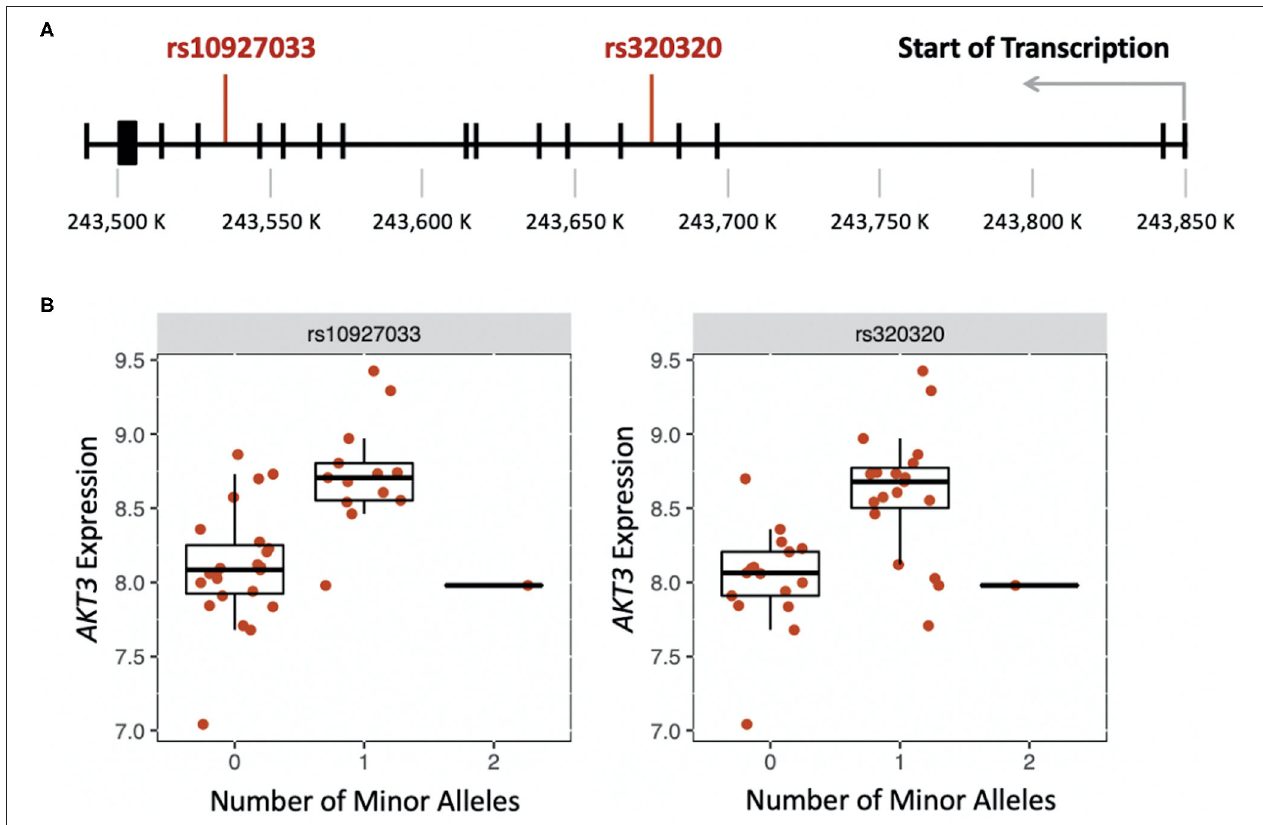
FIGURE 2 | (A) Location of genetic variants that influence expression of AKT3 in the late-phase response (FDR < 0.01). (B) Boxplots showing the effect of the number of minor alleles on AKT3 expression for each genetic